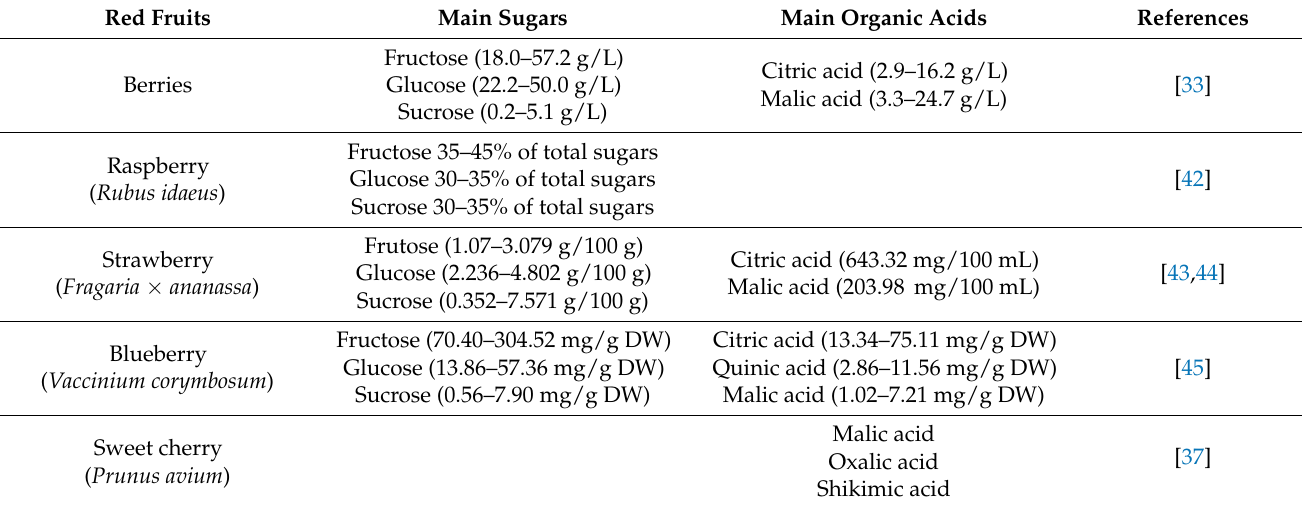
Table 3. The average content of main sugars and organic acids in different types of red fruits.